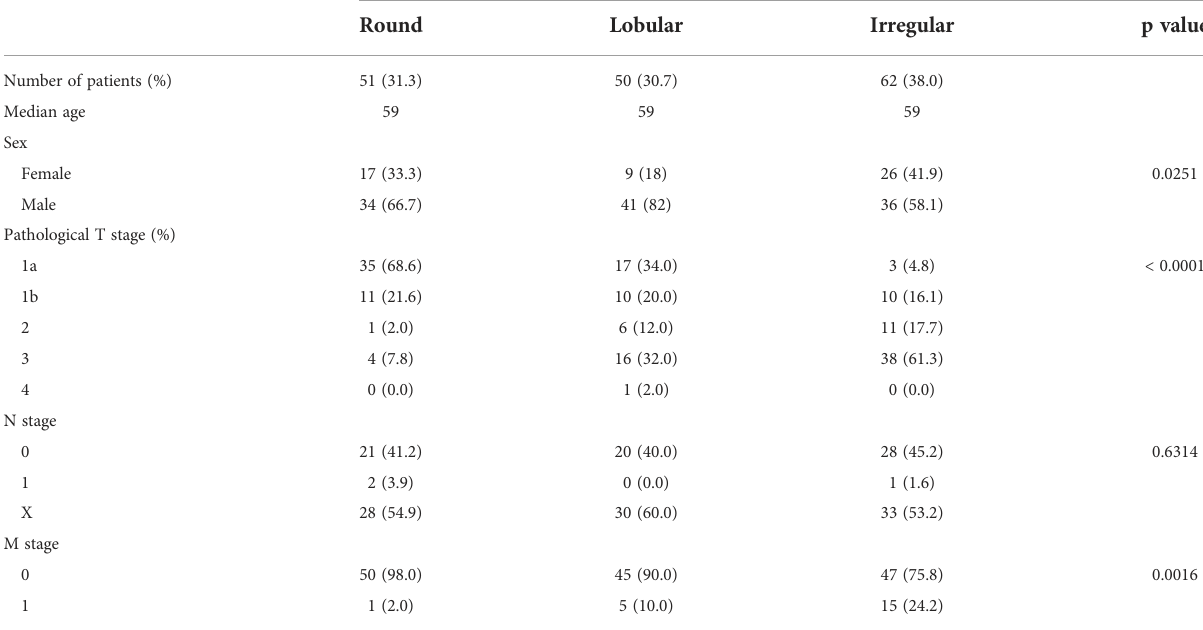
TABLE 1 Patient background comparison for each morphological classi fi cation of ccRCC in TCIA data sets.